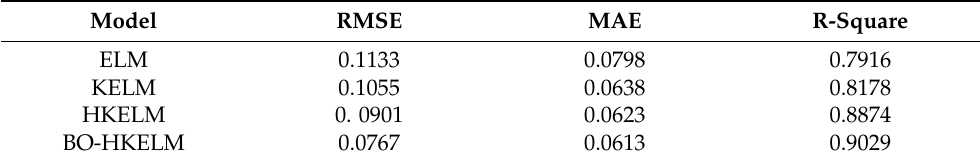
Table 4. The outcomes of estimating RHOB in Well A2 using the trained models from Well